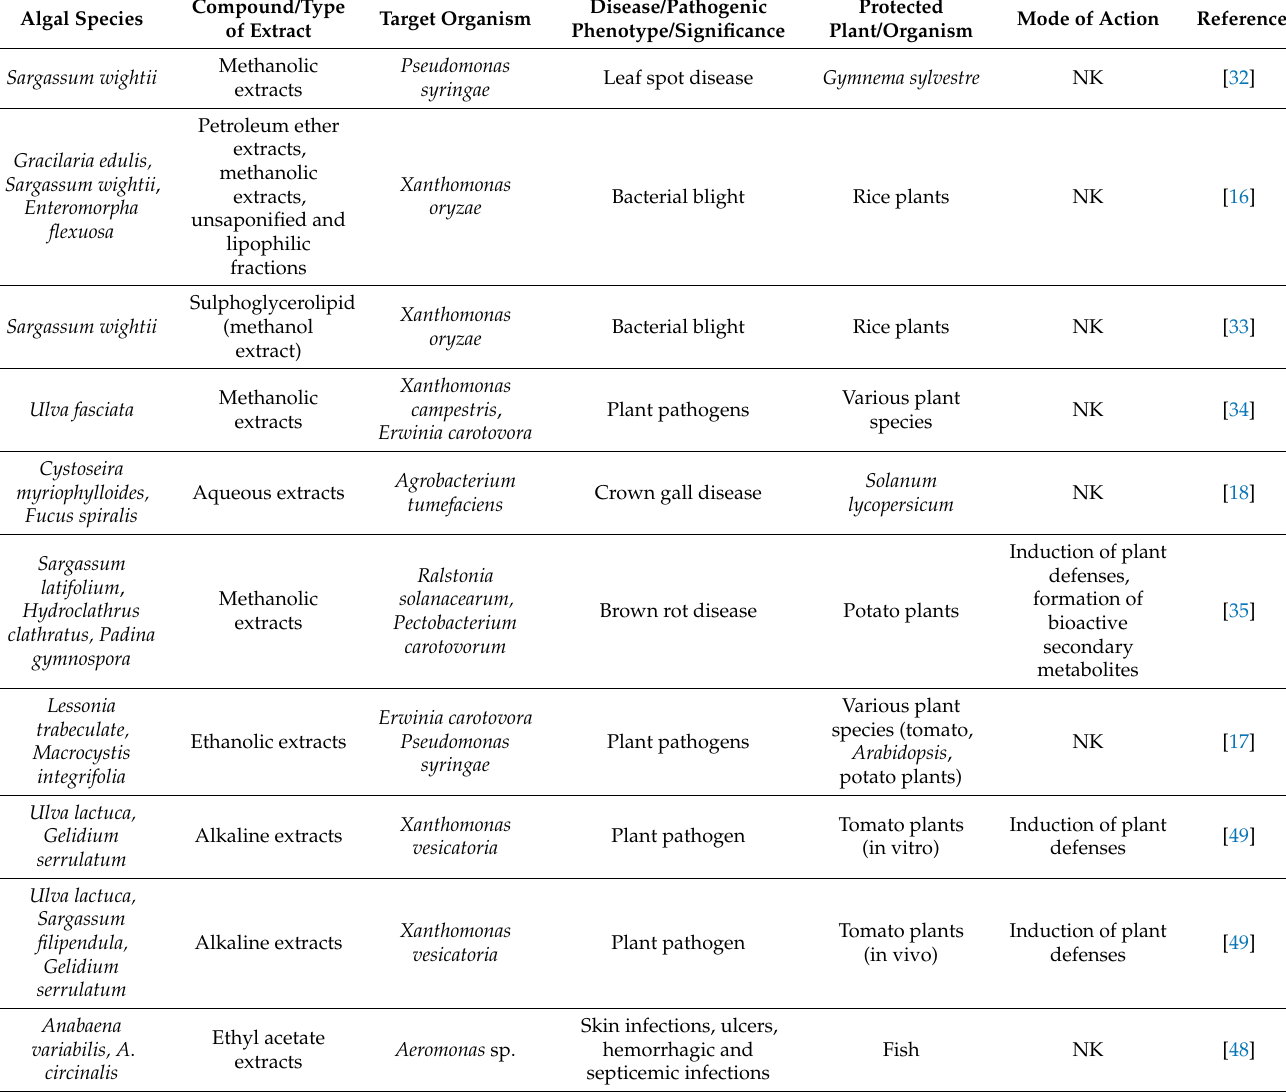
Table 1. Summary of algal compounds and their antibacterial